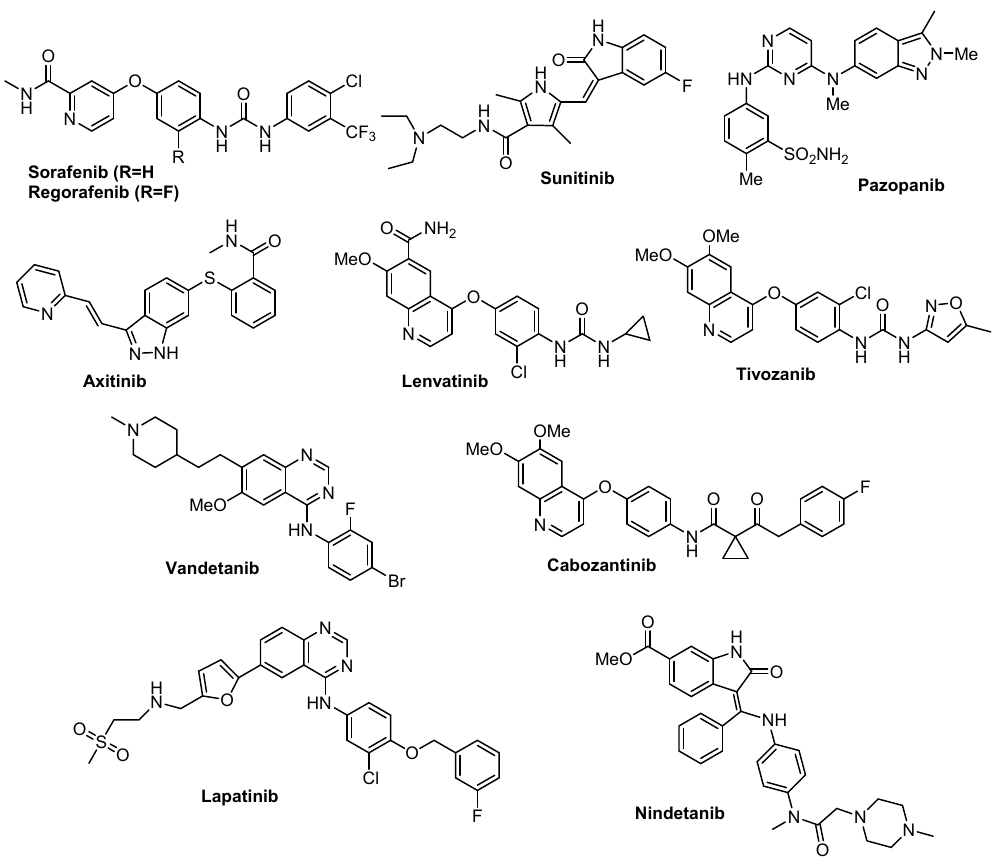
Figure 2. Clinically approved VEGFR inhibitors.